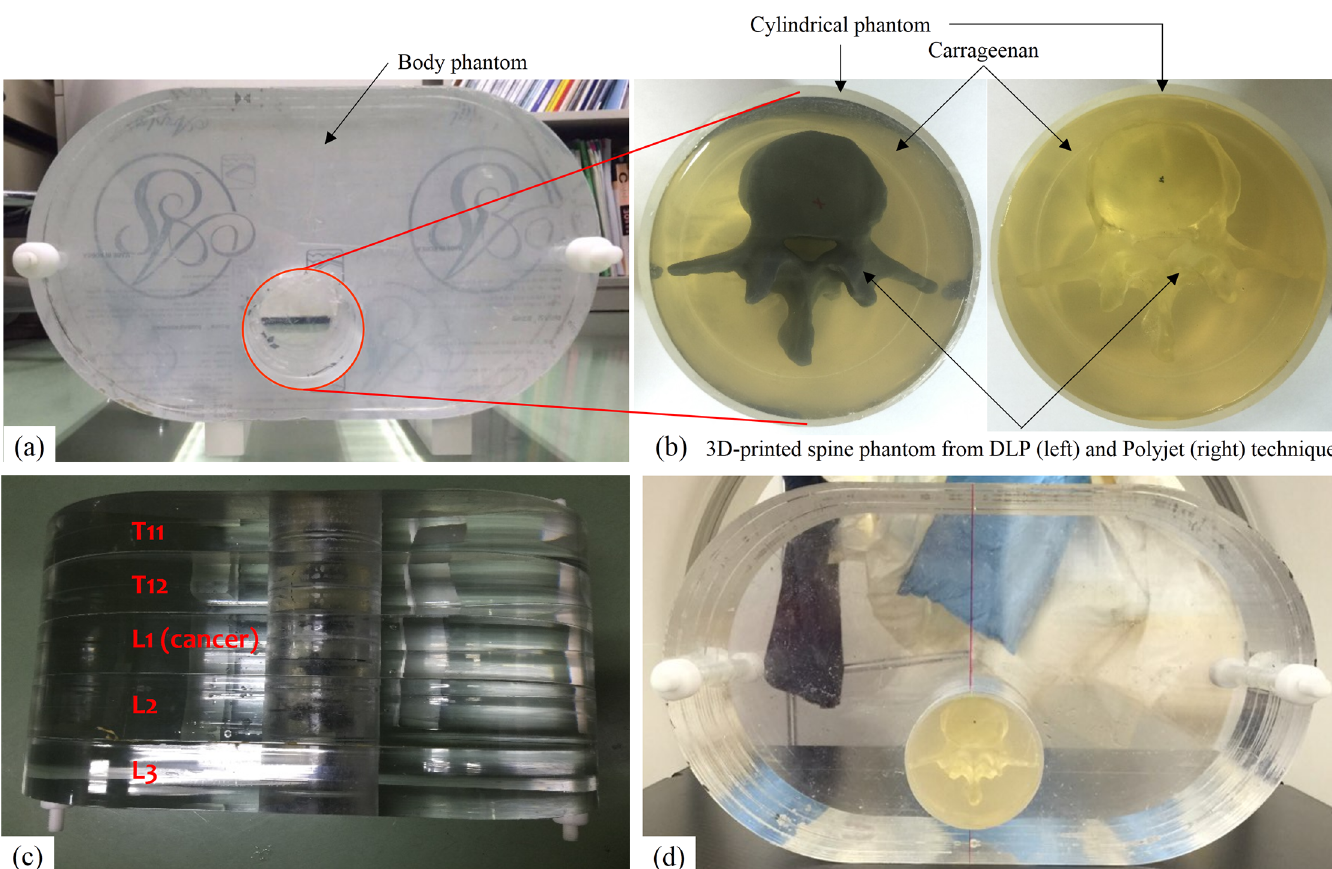
Fig 2. (a) Acrylic body phantom(b) 3D printed spine phantom generated by the DLP technique(left) and the Polyjet technique(right) fixed to a cylindrical phantomwith carrageenan(c) Top view of the developed3D printed spine qualityassurance(QA) phantom, which consists of five slabs (d) Front view of the developed 3D printed spine QA